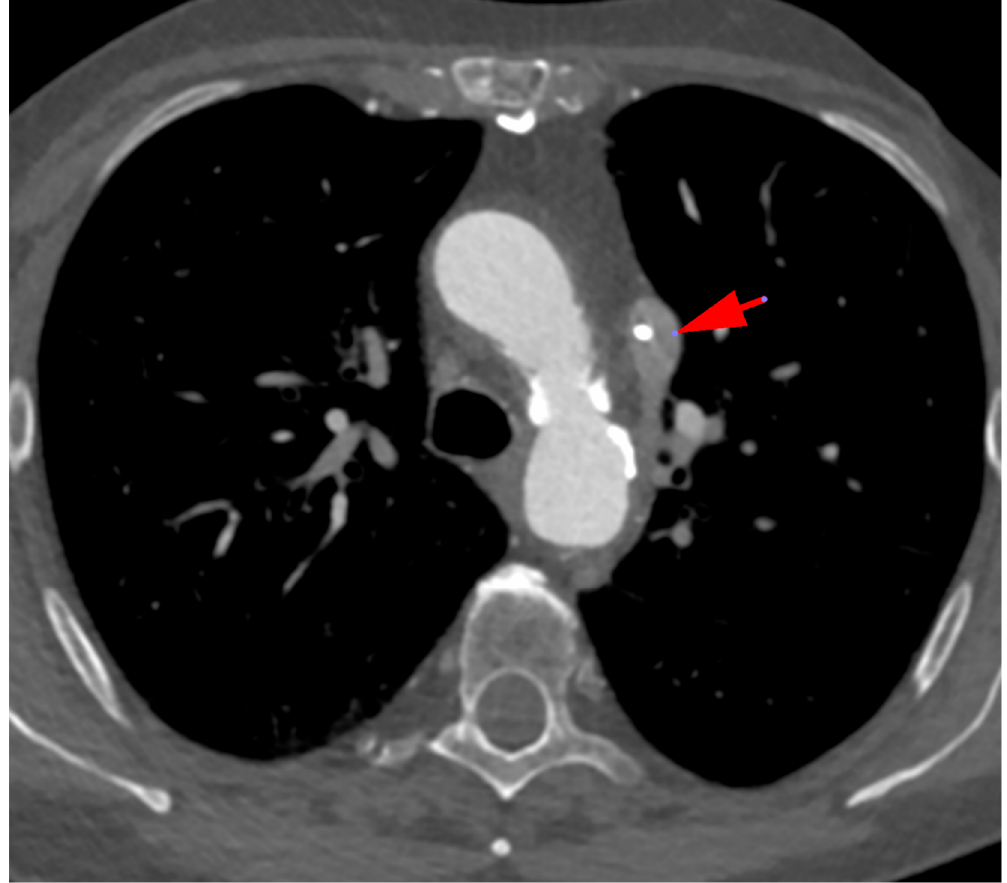
Figure 1. Persistent left superior vena cava (SVC) with absent right SVC. The computed tomography image in the MIP reconstruction, in the coronal view connecting with the right subclavian vein into the right brachiocephalic vein (red star), vein connecting with the subclavian vein the left brachiocephalic vein (blue star), the atypical course of the right brachiocephalic vein crossing the proximal branches of the aortic arch from the